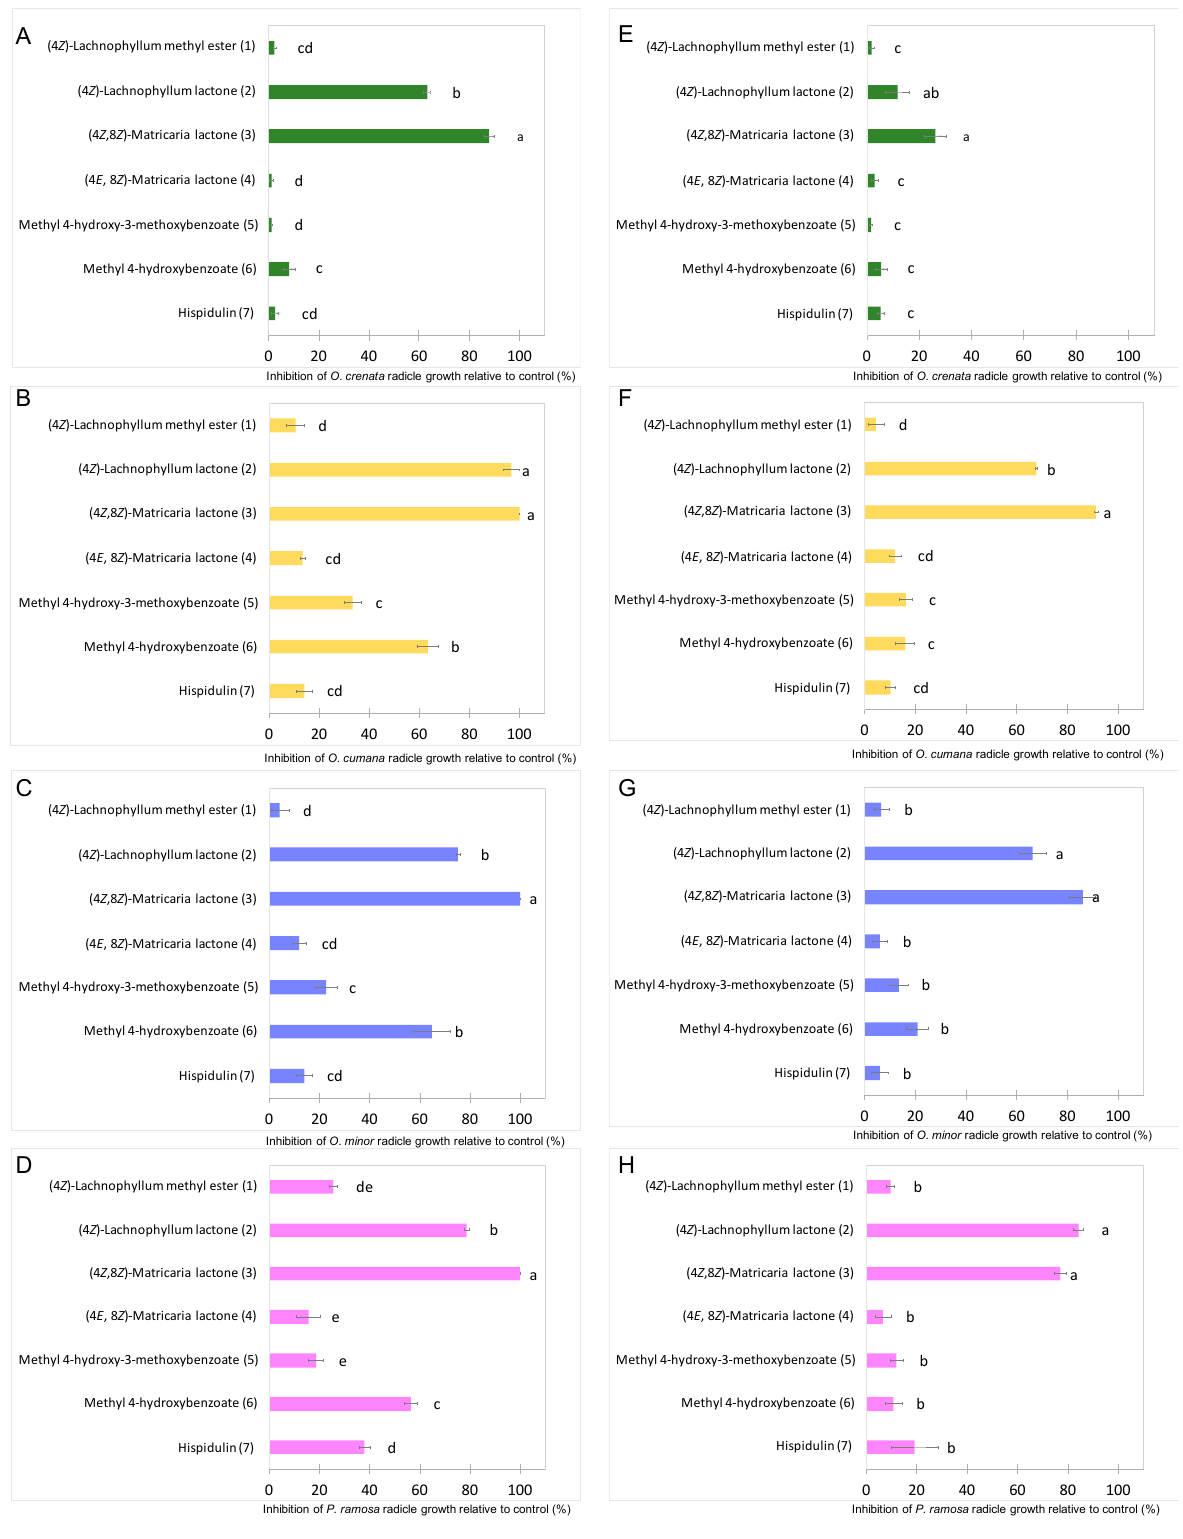
Figure 3. Growth inhibition induced by (4 Z )-lachnophyllum methyl ester ( 1 ); (4 Z )-lachnophyllum lactone ( 2 ); (4 Z ,8 Z )-matricaria lactone ( 3 ), (4 E ,8 Z )-matricaria lactone ( 4 ); methyl 4-hydroxy-3-methoxybenzoate ( 5 ); methyl 4-hydroxybenzoate ( 6 ); hispidulin ( 7 ); applied at 1mM ( A – D ); and 0.1mM ( E – H ); in radicles of O. crenata ( A , E ); O. cumana ( B , F ); O. minor ( C , G ); and P. ramosa ( D , H ); bars with different letters are significantly different according to the Tukey test ( p < 0.05). Error bars represent the standard error of the